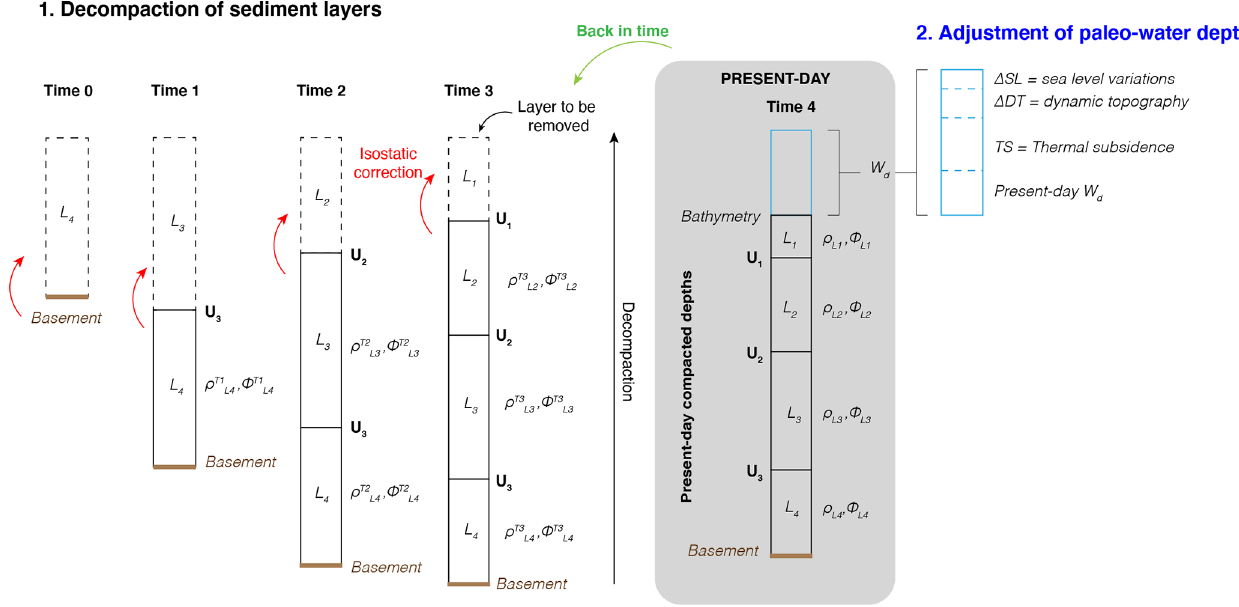
Figure 2. The backtracking procedure used in PALEOSTRIP is as follows. Sediment layers L are separated by well-defined seismic or lithological unconformities U . All the sediment layers have different lithological properties defined by their porosity φ and density ρ . These two properties change during the decompaction process, departing from the present-day depth of sediment layers, as buried sediments are unloaded from the upper sediment layers (isostatic correction). The water depth at each time step is calculated using a time-varying thermal subsidence model (Eq.